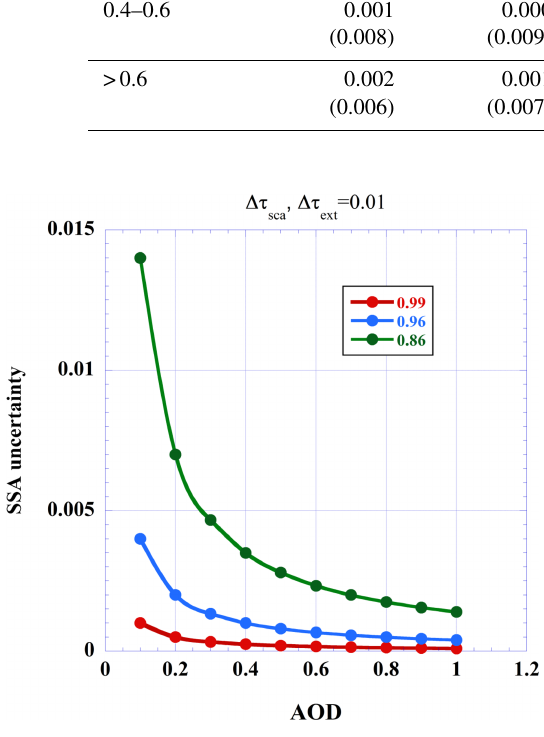
Figure 11. The uncertainty in SSA simulated using Eq. (1) for the three values of SSA: 0.99 (red), 0.96 (blue) and 0.86 (green).